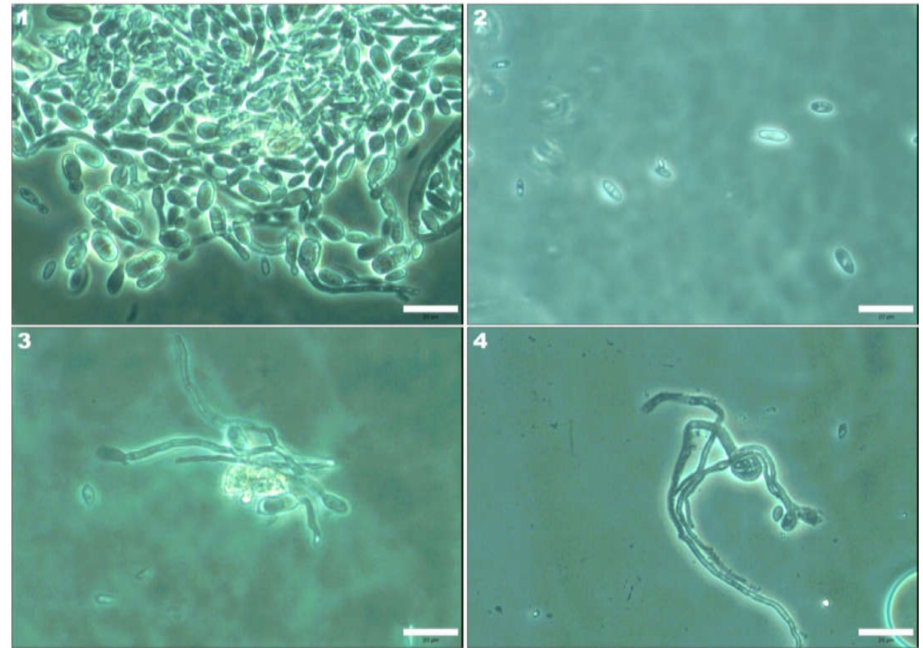
Figure 5. Morphology of A. pullulans cells observed by light microscopy: ( 1 ) control; ( 2 ) P-1; ( 3 ) P-2; ( 4 ) P-3 (scaling bar: 20 µ m).